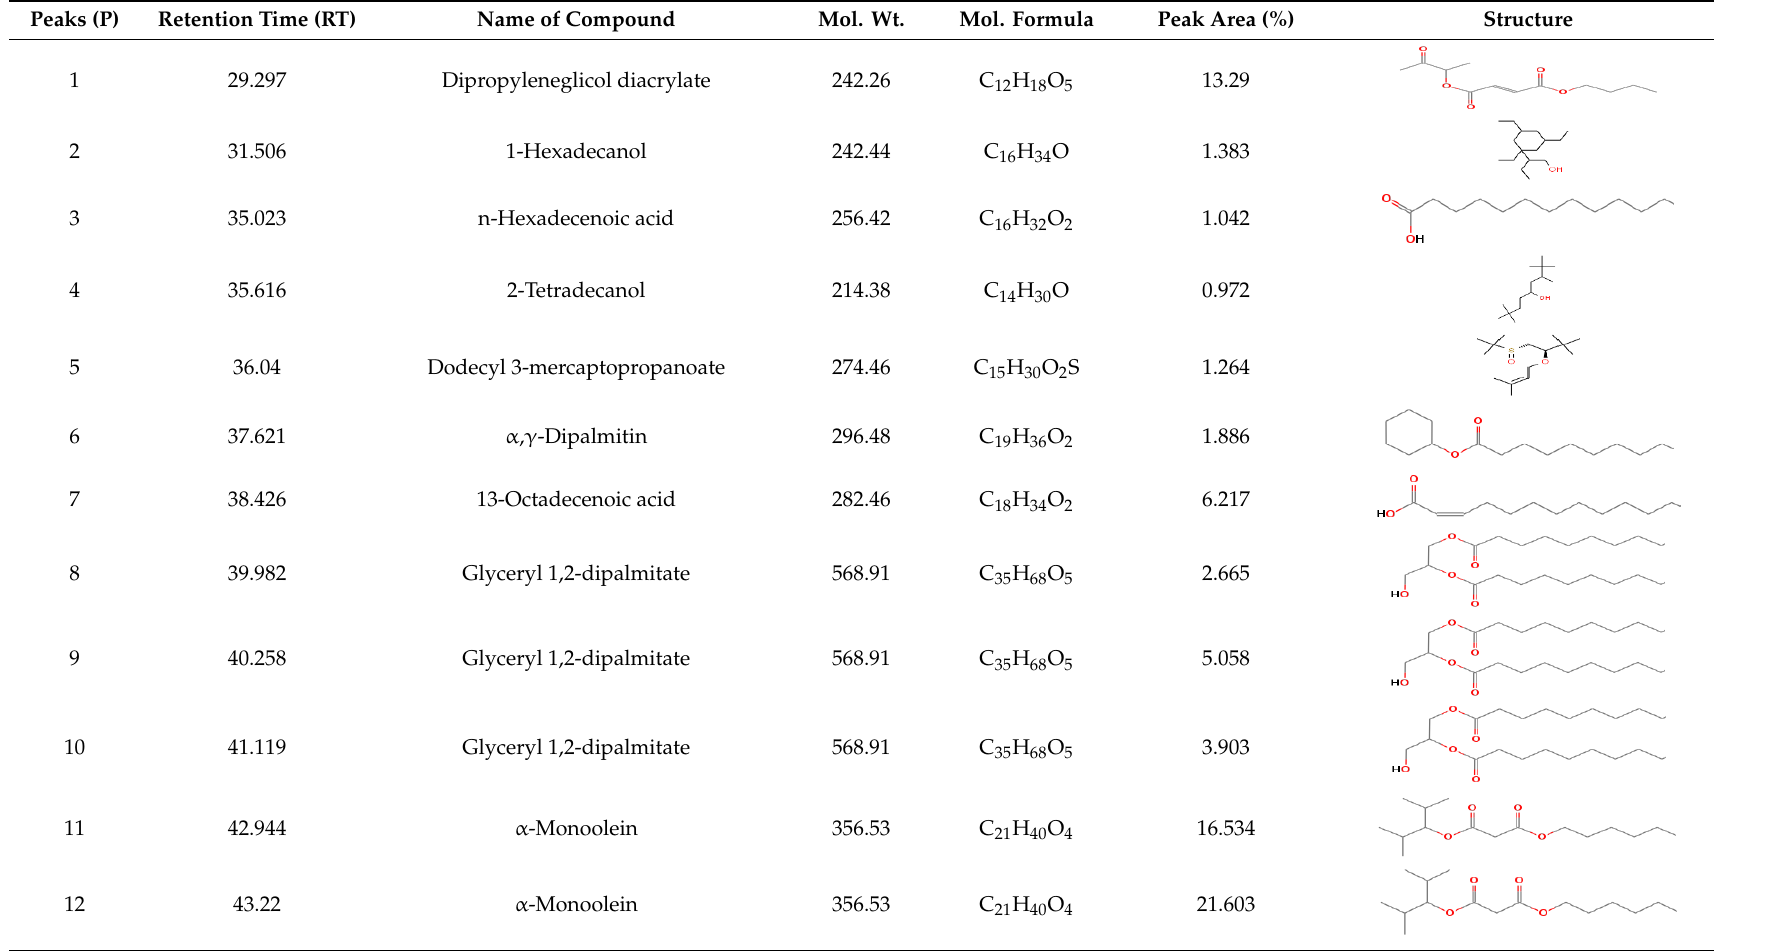
Table 1. GC-MS analysis of CLE leaf Table 1. GC-MS analysis of CLE leaf extract. Table 1. GC-MS analysis of CLE leaf extract. Table 1. GC-MS analysis of CLE leaf extract. Table 1. GC-MS analysis of CLE leaf extract. Table 1. GC-MS analysis of CLE leaf extract. Table 1. GC-MS analysis of CLE leaf extract. Table 1. GC-MS analysis of CLE leaf extract. Table 1. GC-MS analysis of CLE leaf extract. Table 1. GC-MS analysis of CLE leaf extract. Table 1. GC-MS analysis of CLE leaf extract. Table 1. GC-MS analysis of CLE leaf extract. Table 1. GC-MS analysis of CLE leaf extract.